Question: What kind of plot is shown here?
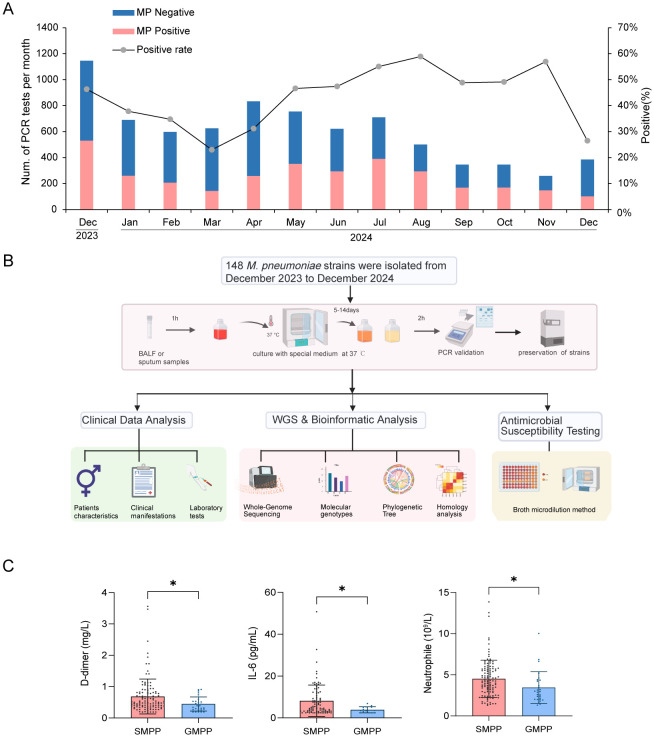
Answer: line